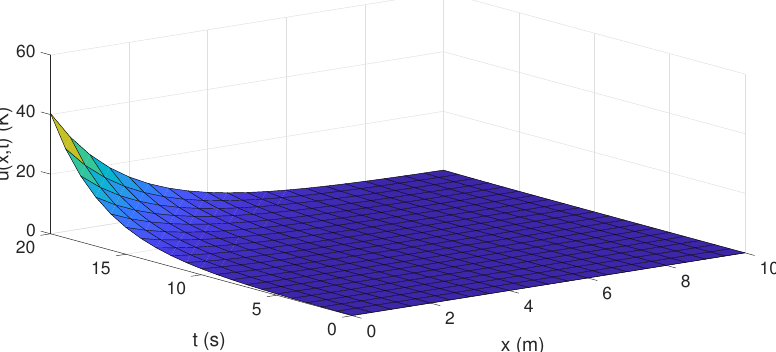
Figure 3. Scalar field resulting from Equation (17) with β 1 = 0.5, β 2 = 0, β 3 = 0, β 4 = 0.1, β 5 = 0, and α = 1.2.